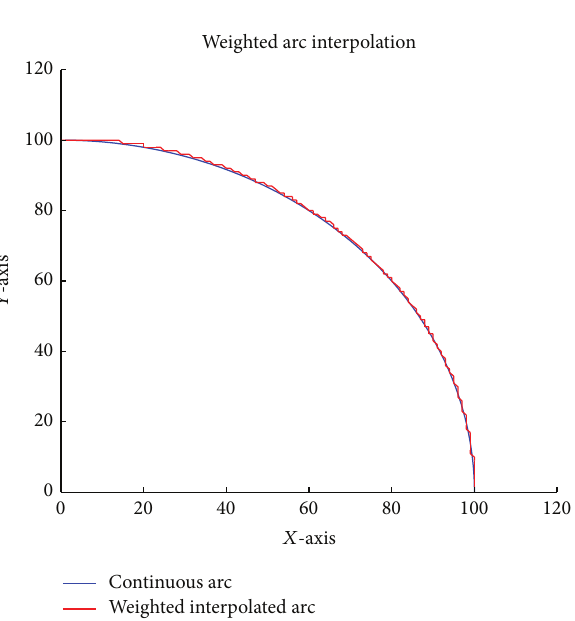
Figure 4: Example of DDA arc interpolation.